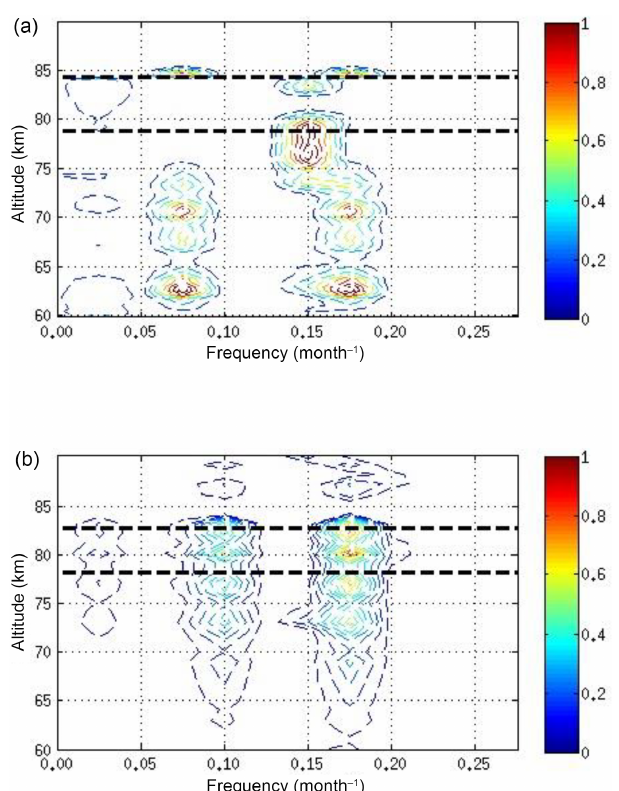
Figure 8. Normal frequency spectrum of the monthly mean temper- ature profiles obtained from lidar observation over (a) Mauna Loa and (b) Réunion. The black line indicates the temperature inversion